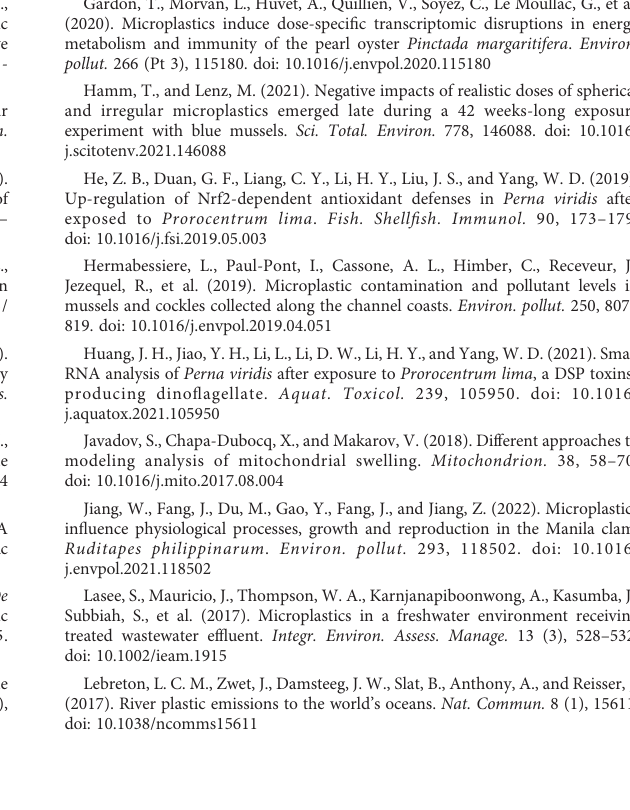
SUPPLEMENTARY FIGURE 1 Images of microplastics (MPs) in the fl uorescence microscope. SUPPLEMENTARY FIGURE 2 The number of sequence of different sizes. SUPPLEMENTARY FIGURE 3 Venn diagram of gene number in different treatment. SUPPLEMENTARY FIGURE 4 Venny maps of the DEGs in M. coruscus after MP and P. lima exposure. SUPPLEMENTARY FIGURE 5 The GO functional classi fi cation of DEGs in M. coruscus after MP and P. lima exposure. SUPPLEMENTARY FIGURE 6 Heatmap analysis of antioxidant and detoxi fi cation-related gene expression analysis in different groups. CK: control; LM: P. lima exposure; LM_MPs1: P. lima and 0.2 mg/L MPs exposure; MPs1: 0.2 mg/ L MPs exposure. The small panel with a color gradient represents the changes in gene expression levels from down-regulated (green) to up- regulated